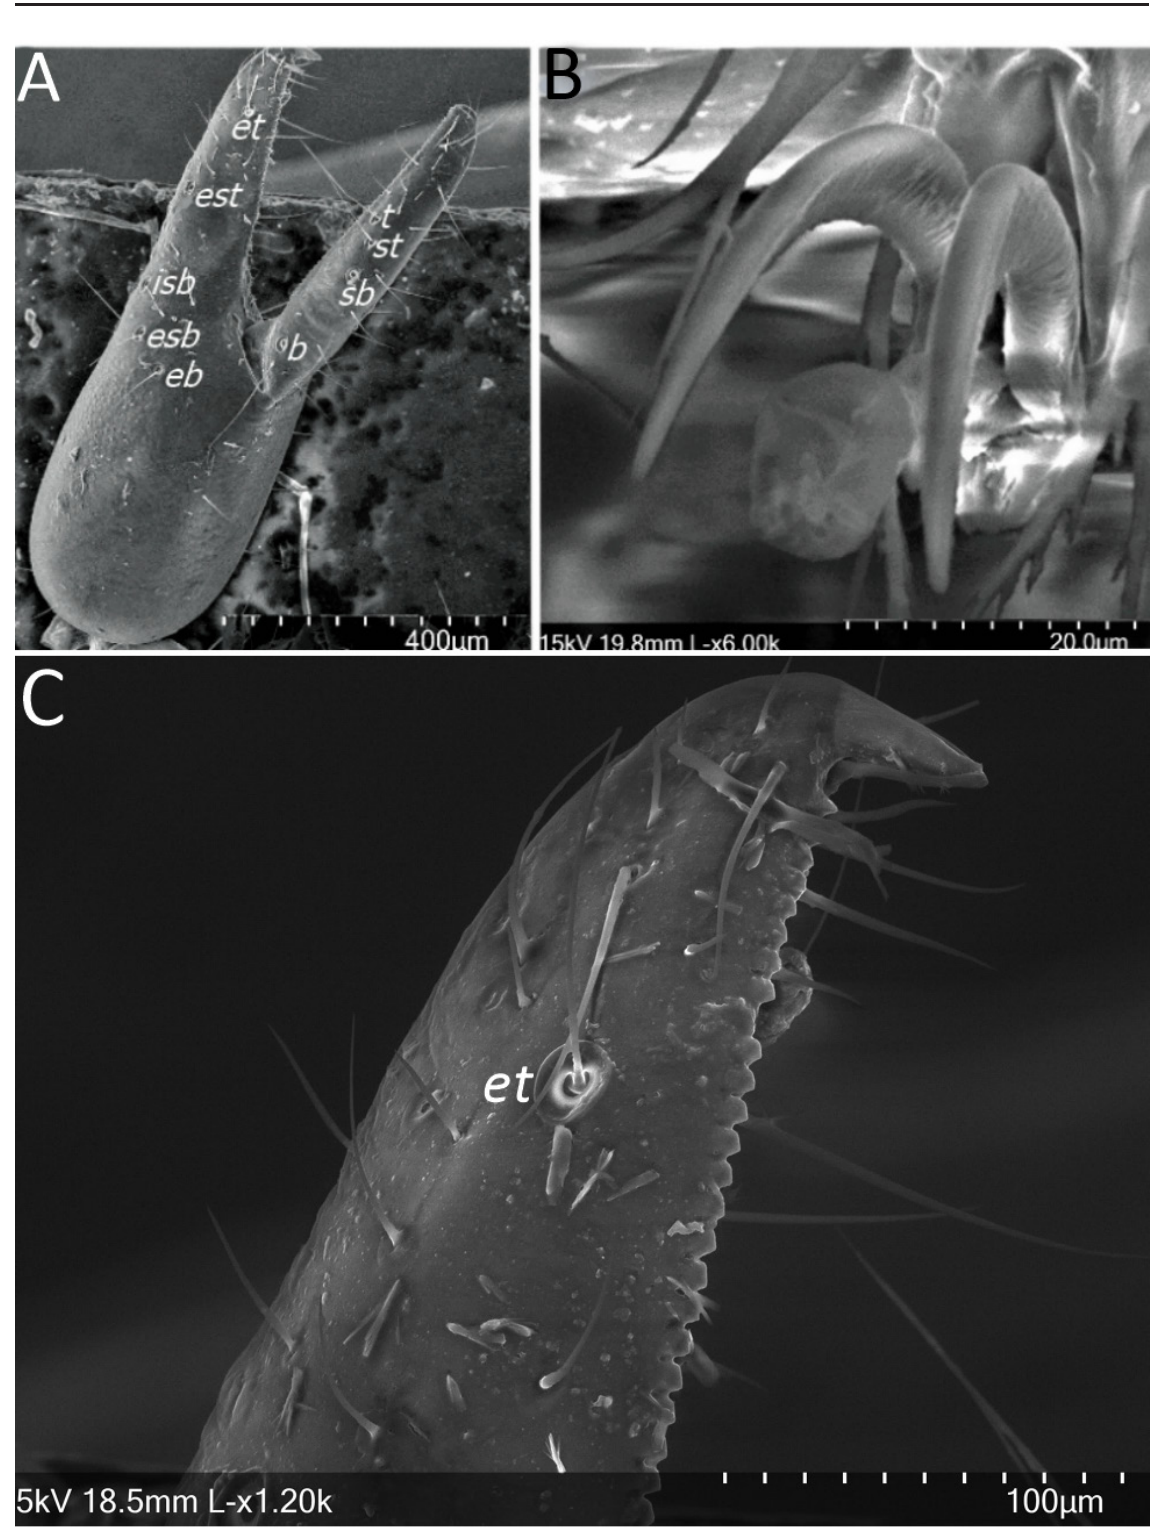
Fig. 28. Scanning electron micrographs of Ideoblothrus safinai sp. nov., paratype, ♂ (ZMH A0015395). A . Chela in retrolateral view, showing trichobothria. B . Claw and arolium, showing broadened end. C . Close-up of chelal tip of fixed